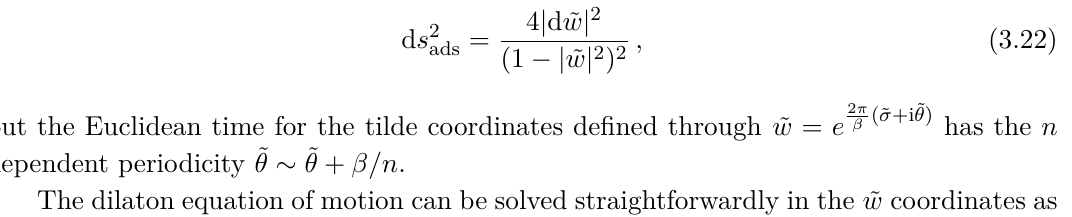
2 disk with the inverse